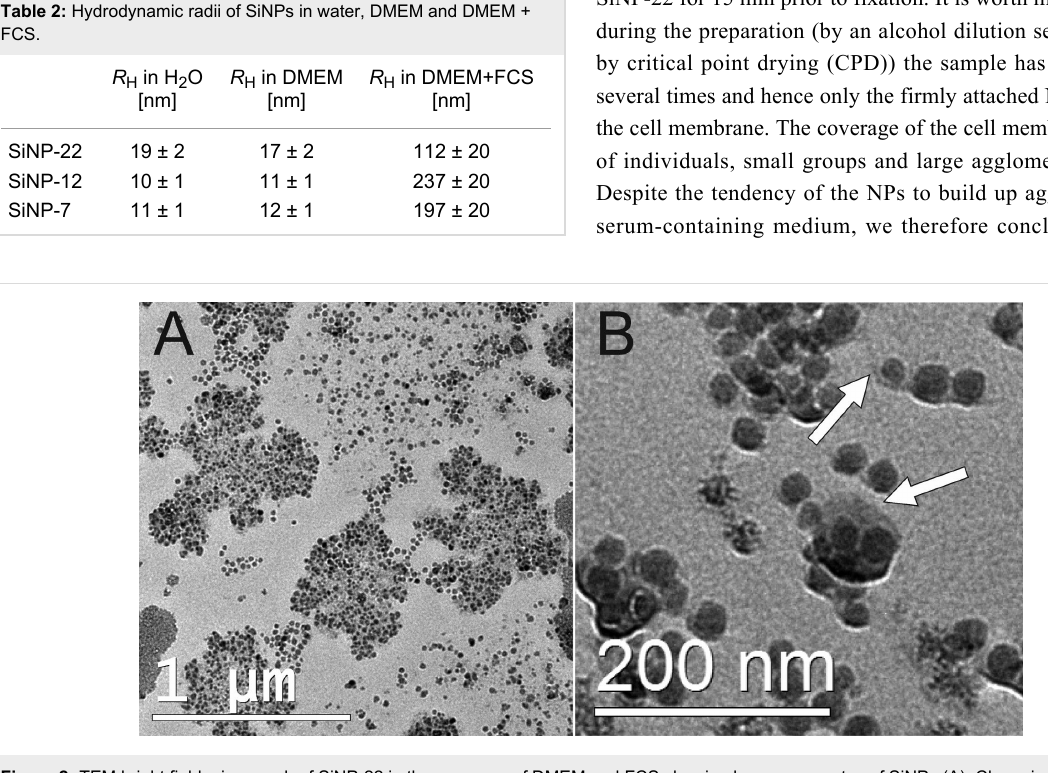
Figure 2: TEM bright field micrograph of SiNP-22 in the presence of DMEM and FCS showing large aggregates of SiNPs (A). Closer inspection of the silica particles even displays their coverage with a presumably organic / protein layer (arrows in B).